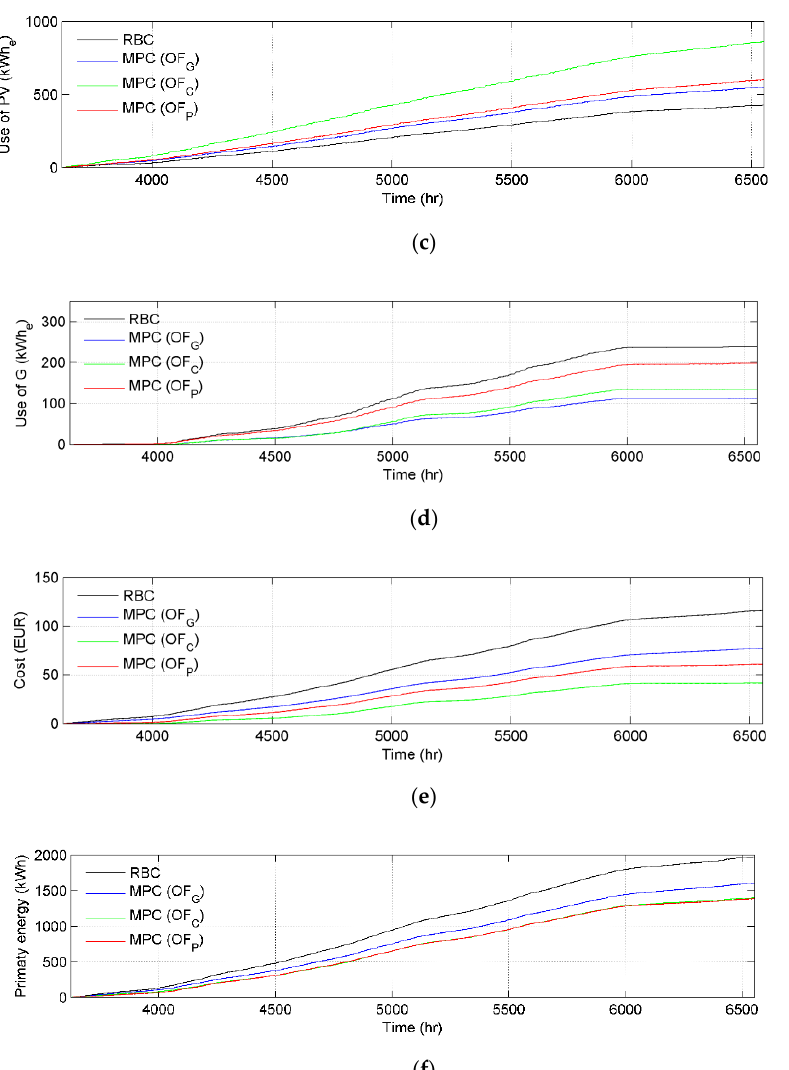
Figure 21. Comparison between RBC, OF G , OF C and OF P in the MPC for the whole cooling season ( PH = 18 h) in terms of: ( a ) total cooling demand; ( b ) use of DC; ( c ) use of PV; ( d ) use of G; ( e ) cost and ( f ) primary energy